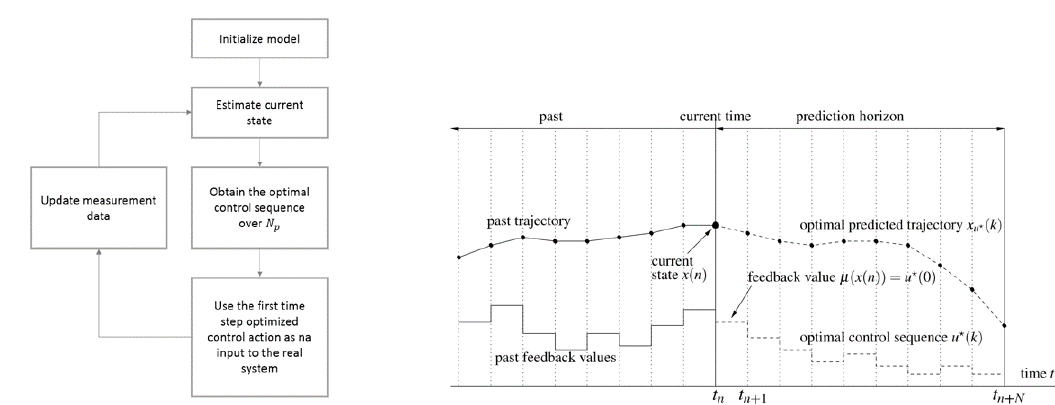
Figure 3. Flowchart of model predictive control (MPC) ( left ) and illustration of prediction horizon ( right